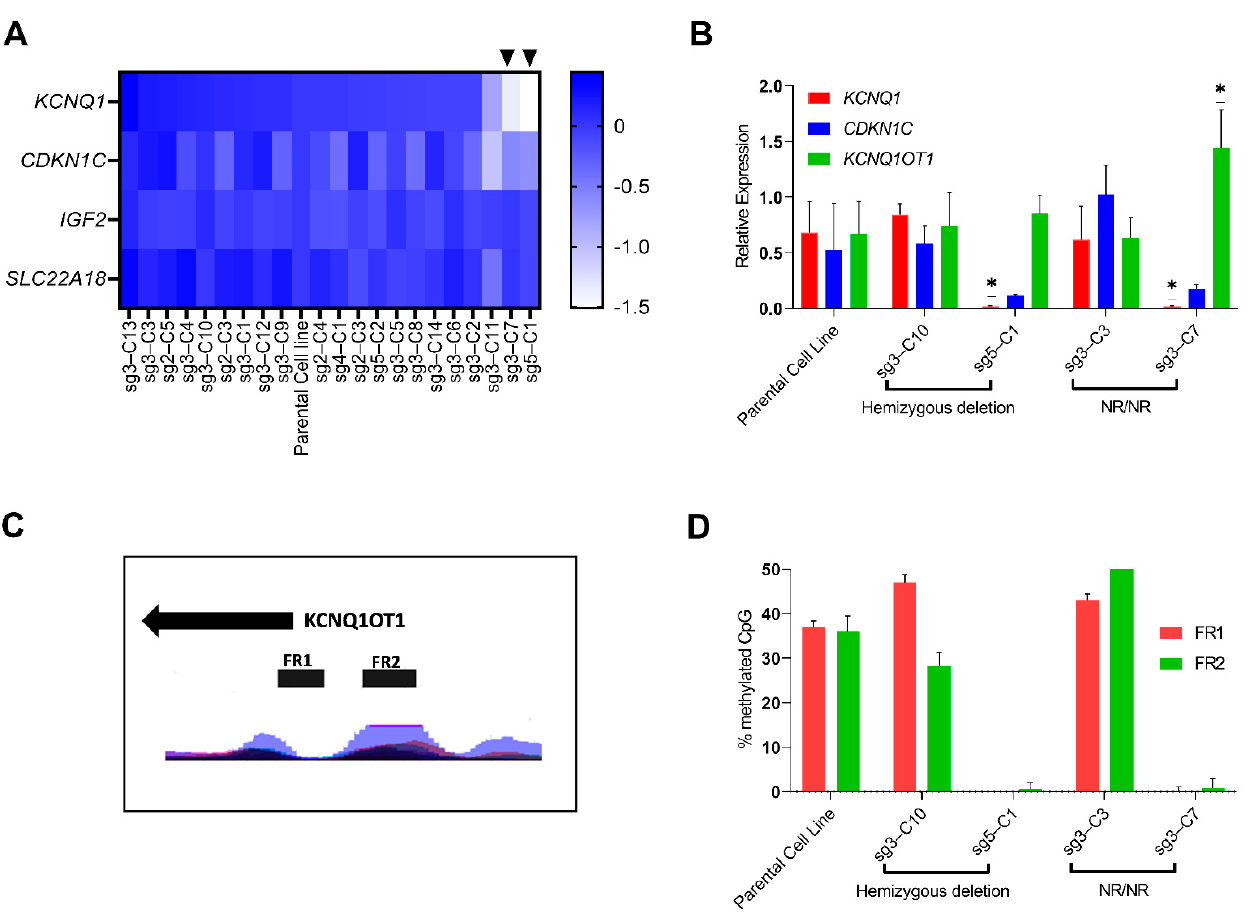
Figure 4. Identification of clonal cell lines with hypomethylation at the KCNQ1OT1 promoter region resulting in downregulation of KCNQ1 . ( A ). Heat map showing expression (logFC) of KCNQ1 , CDKN1C , IGF2 and SLC22A18 in the clonal cell lines relative to expression in the parental cell line. Data is using RNA from a single passage. Arrows heads show cell lines with downregulation of KCNQ1 . ( B ). Relative expression of KCNQ1 , CDKN1C and KCNQ1OT1 in selected clonal cell lines. Clones sg3-C10 and sg5-C1 had hemizygous deletions in different alleles and of different size and clones sg3-C3 and sg3-C7 had edits resulting in homozygous non-risk alleles at the KCNQ1 locus. Relative expression was normalized to the expression of TBP. RNA from three different passages were used for the experiment. Error bars show SD and results were compared using t -test, * p < 0.05. ( C ). Layered H3K27Ac marks in 7 cell lines from ENCODE in the region captured by FR1 and FR2 used for bisulfite sequencing to analyze methylation at the KCNQ1OT1 promoter. ( D ). Average methylation across 49 CpG sites in the KCNQ1OT1 promoter region assessed by bisulphite sequencing. Two different regions were assessed, FR1 (23 CpG sites) and FR2 (26 CpG sites). Error bars show